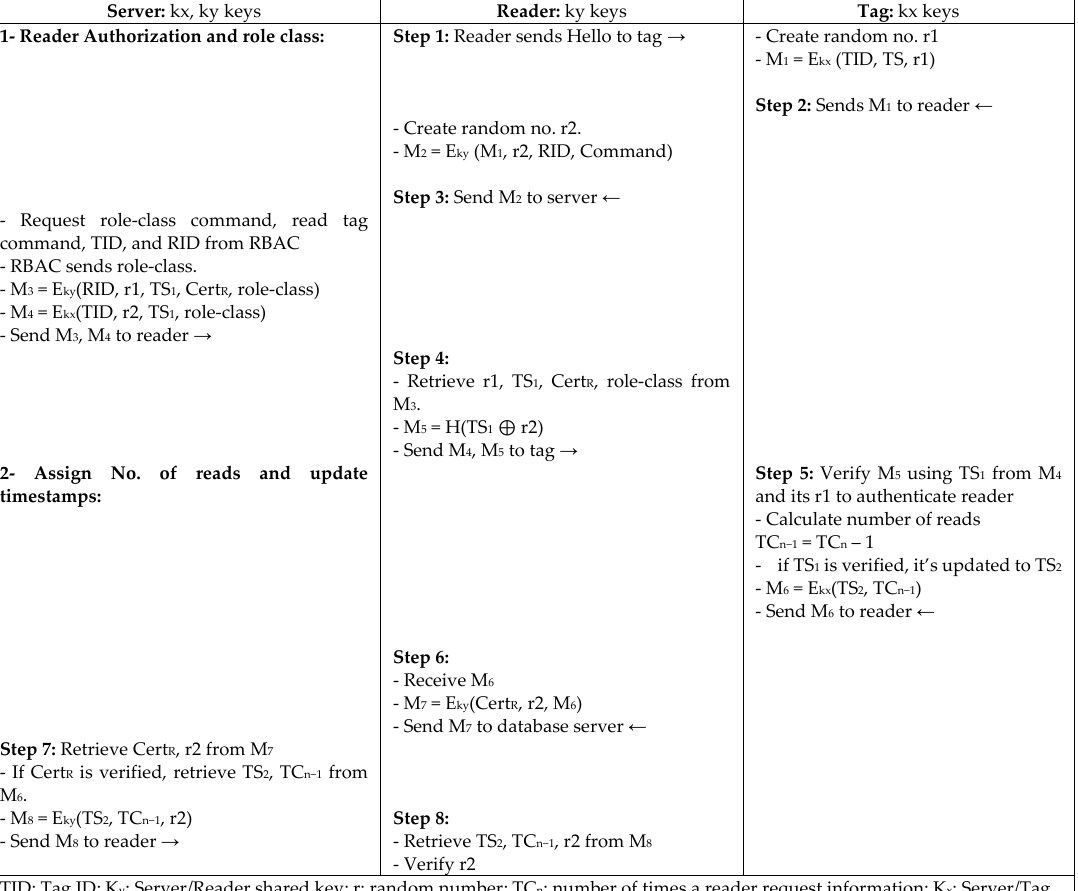
Figure 7. Role-Based Access Control Protocol (RBAC) by B. Chen.